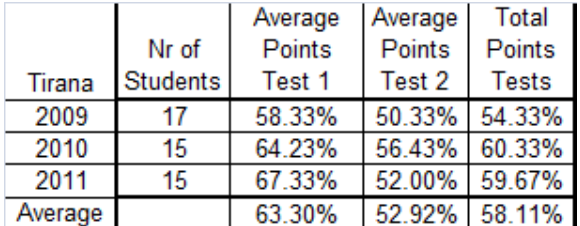
Table 8 Test Points for Tirana Master